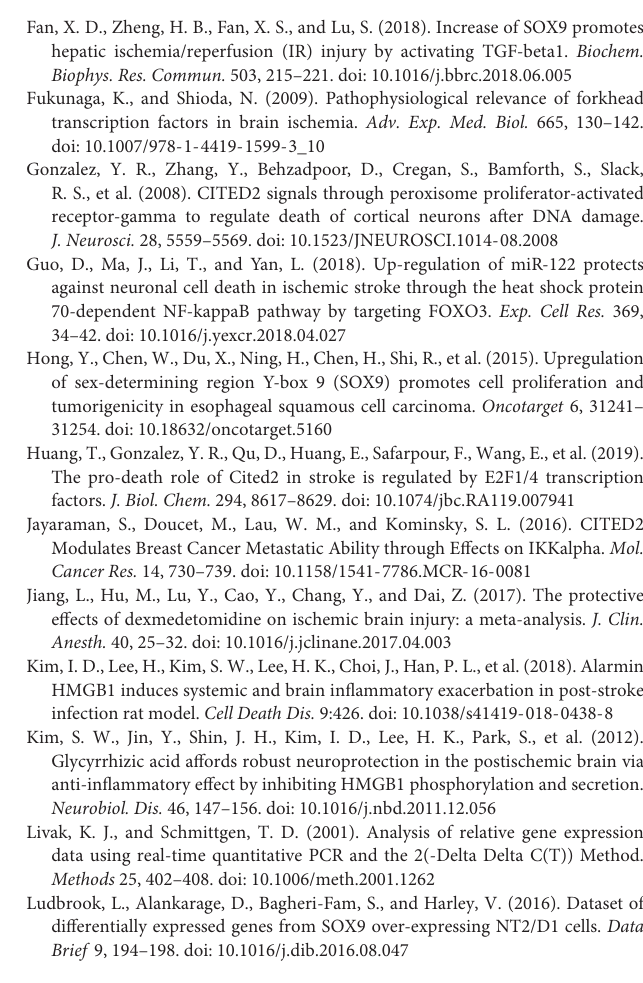
Supplementary Figure 1 | SOX9 silencing restrains neuronal damage through upregulating the FOXO3/IKK α . Western blot analysis of neuronal damage markers (NSE, S-100B, and GFAP) normalized to β -actin in OGD-exposed neurons after infection with lentivirus expressing sh-SOX9, and/or oe-FOXO3 or oe-IKK α . Supplementary Figure 2 | SOX9 silencing restrains neuronal damage through upregulating the FOXO3/IKK α in MCAO-operated rats. Western blot analysis of neuronal damage markers (NSE, S-100B, and GFAP) normalized to β -actin in MCAO-operated rats after delivery of lentivirus expressing sh-SOX9 and/or oe-IKK α